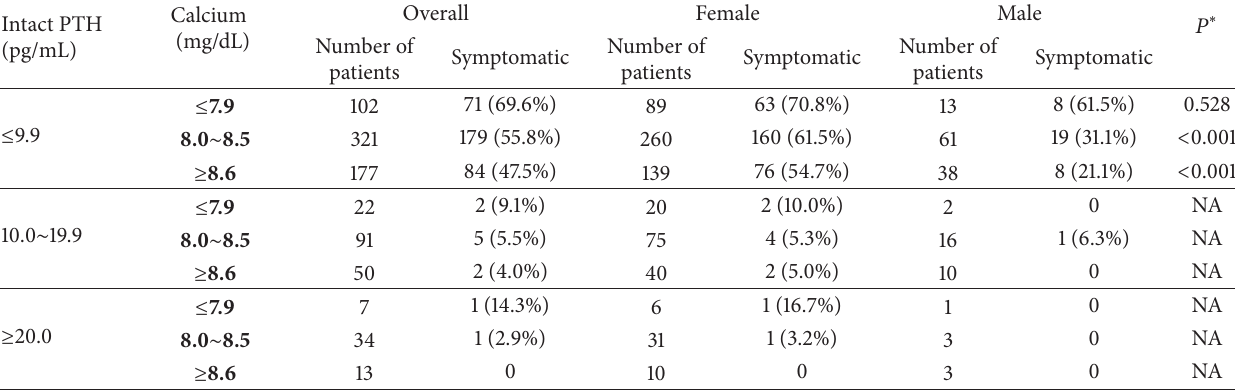
Table 2: Patterns in the development of hypocalcemic symptoms according to serum calcium and intact PTH levels. Intact PTH